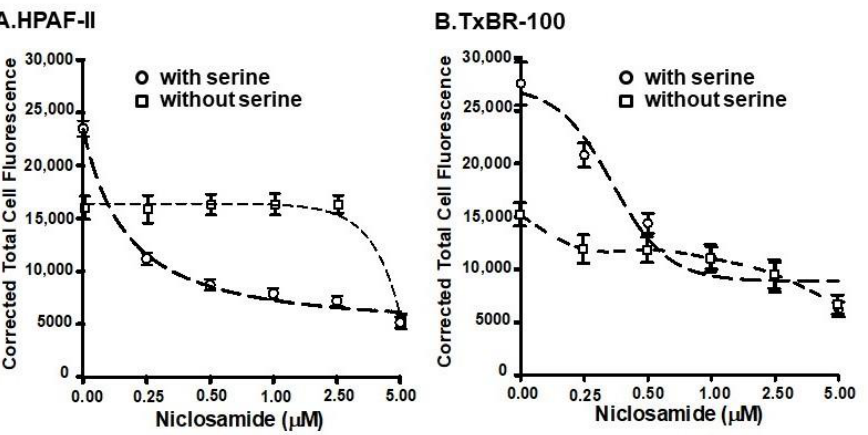
Figure 5. Dose-response for the inhibition of basal and SLC38A5-mediated macropinocytosis (TMR- dextran uptake) by niclosamide in HPAF-II ( A ) and TXBR-100 cells ( B ). Basal macropinocytosis was monitored in a NaCl-buffer without or with varying doses of niclosamide. The assay was done again, but using the NaCl-buffer with serine (1 mM). SLC38A5-mediated macropinocytosis was calculated by subtracting TMR-dextran uptake in NaCl-buffer from that in NaCl-serine buffer. Dose-responses for niclosamide to inhibit basal and SLC38A5-mediated macropinocytosis are shown. 3.6. Direct Inhibition of SLC38A5-Mediated Transport Activity by Niclosamide, but